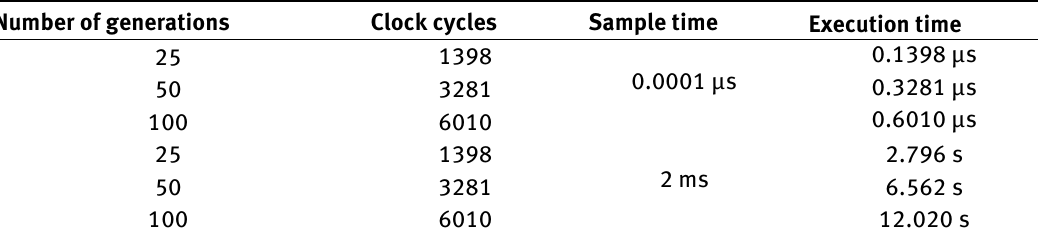
Table 1: FPGA DE/PID execution performance numbers Number of